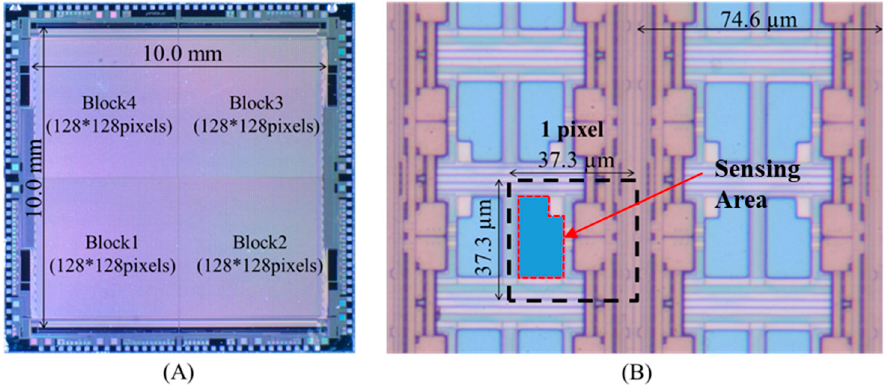
Figure 4. ( a ) A picture of the 256 × 256 array charged couple device (CCD)-type image sensor; ( b ) a micrograph of the sensor